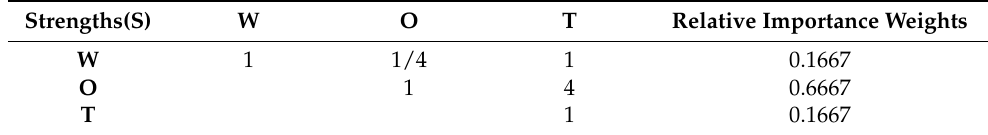
Table A4. The interdependence matrix of the SWOT factors with respect to ”Strengths”.